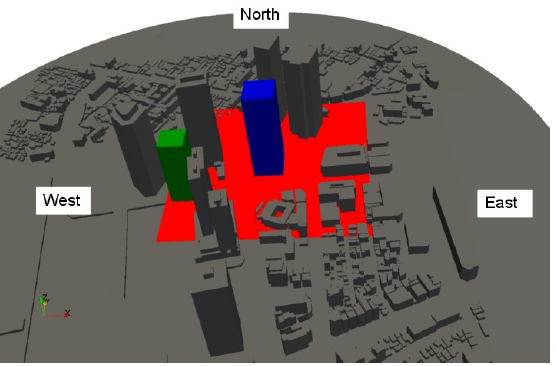
Figure 16. Integration of the new hypothetical buildings in the Shinjuku urban area.